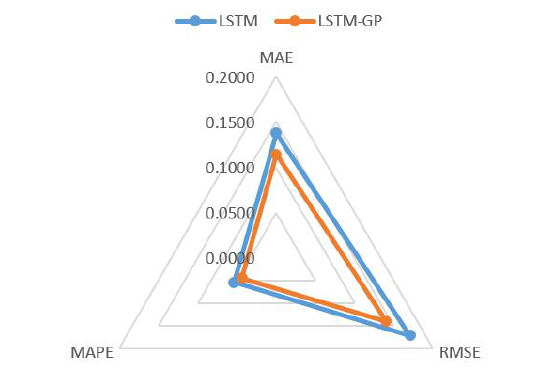
Figure 10. Comparison of prices predicted by the LSTM-GP model and real prices.